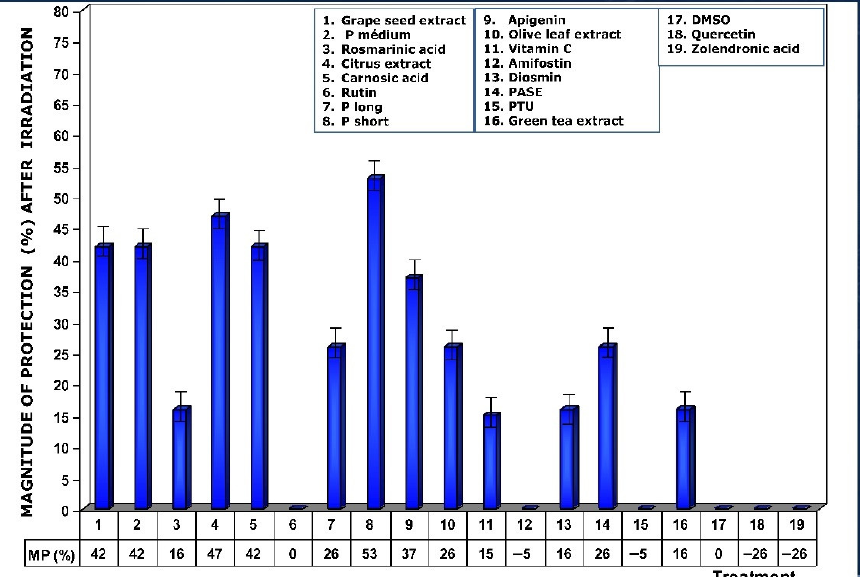
Figure 7. Magnitudes of protection determined when test substances were administered immediately after exposure to ionizing radiation.